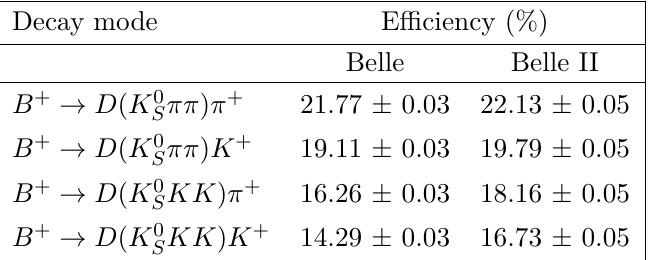
Table 1 . B + → D samples. The uncertainties are statistical